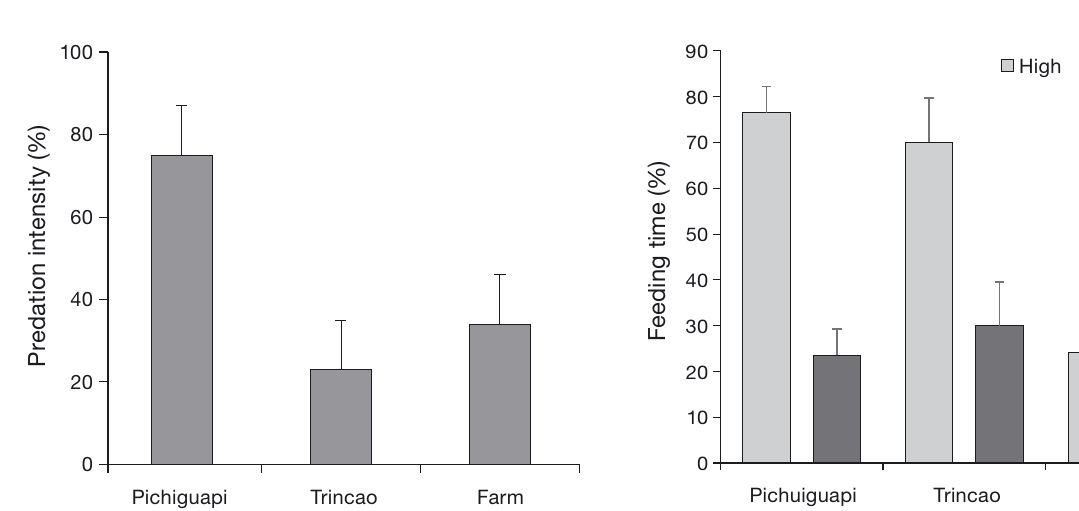
Fig. 3. Mean ± SE predation intensity (population × hours spent feeding) as a percentage of the total observation time that steamer ducks spent at the 3 study polygons within Yal- dad Bay between March 1988 and February 1989